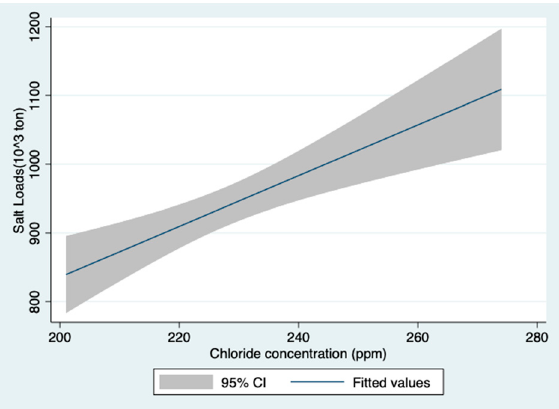
Figure 7. Linear regression (W95% CI) between annual lake means of maximal salt load (10 3 ton) and chloride concentration (ppm) during 1969–2001.